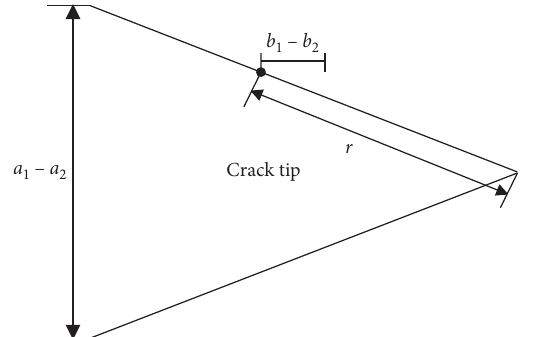
Figure 2: Schematic showing the crack-tip opening displacement.